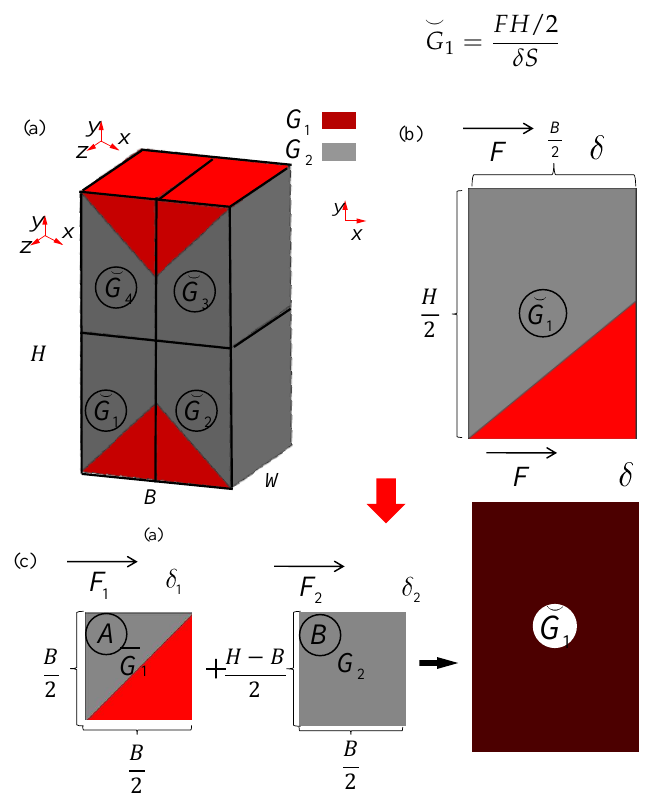
Figure 9. Group concept of macro equivalent shear modulus for multi-layer BCC lattice structures (H > B): ( a ) the whole model; ( b ) the first part; ( c ) the representative unit calculation in x - y plane.